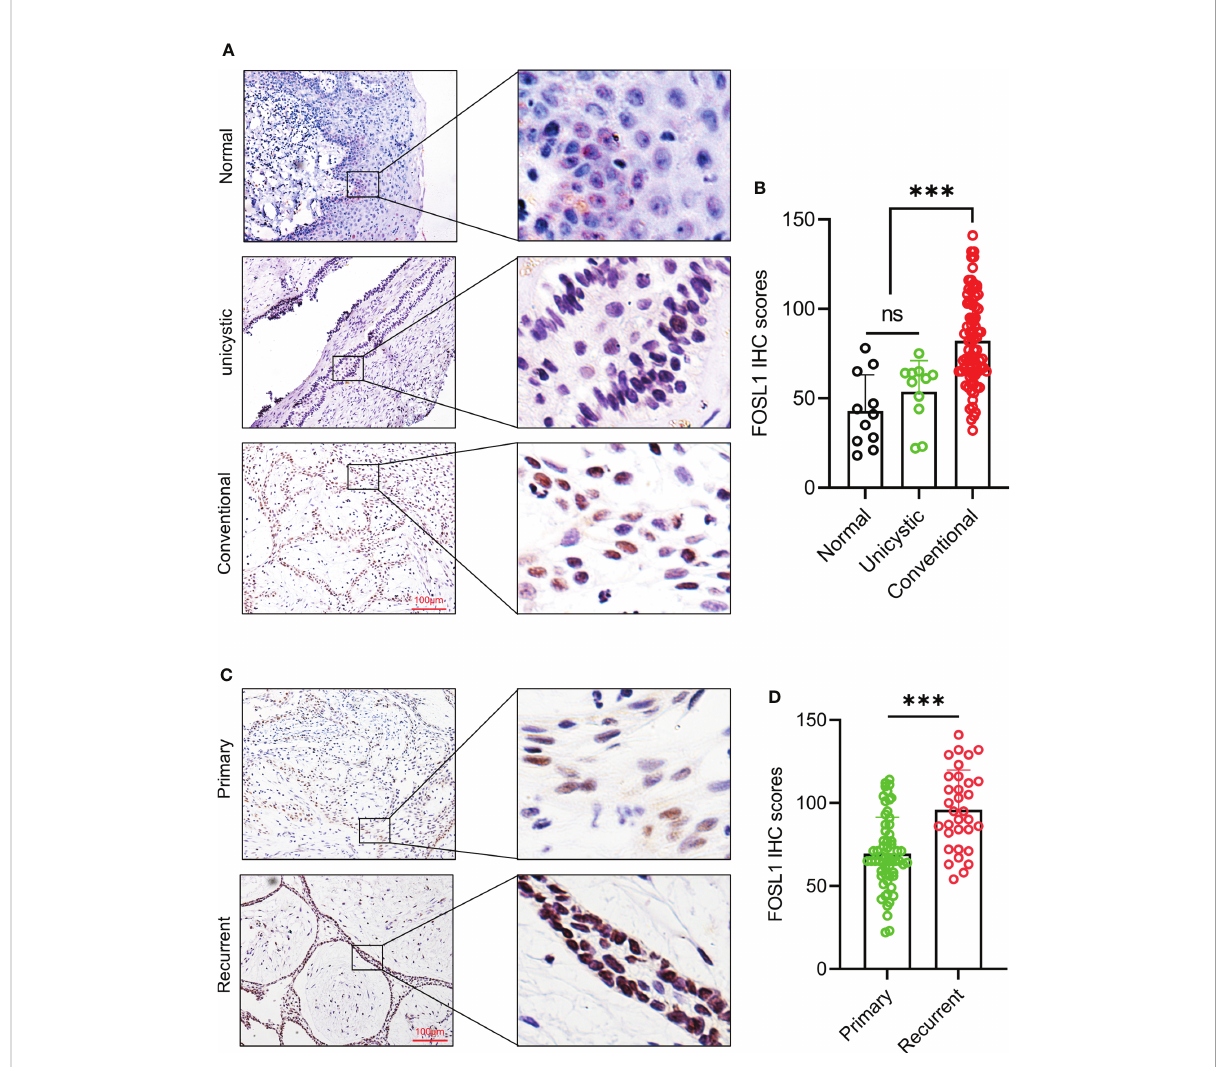
FIGURE 1 Immunohistochemical expression of FOSL1 in AM (A, B) IHC staining images and score quanti fi cation of FOSL1 in normal, unicystic, and conventional AMs. Scale bar: 100 m m. ***p < 0.001 by one-way ANOVA. (C, D) IHC staining images and score quanti fi cation of FOSL1 in primary and recurrent AM. Scale bar: 100 m m. ***p < 0.001 by Student ’ s t-test. NS, no signi fi